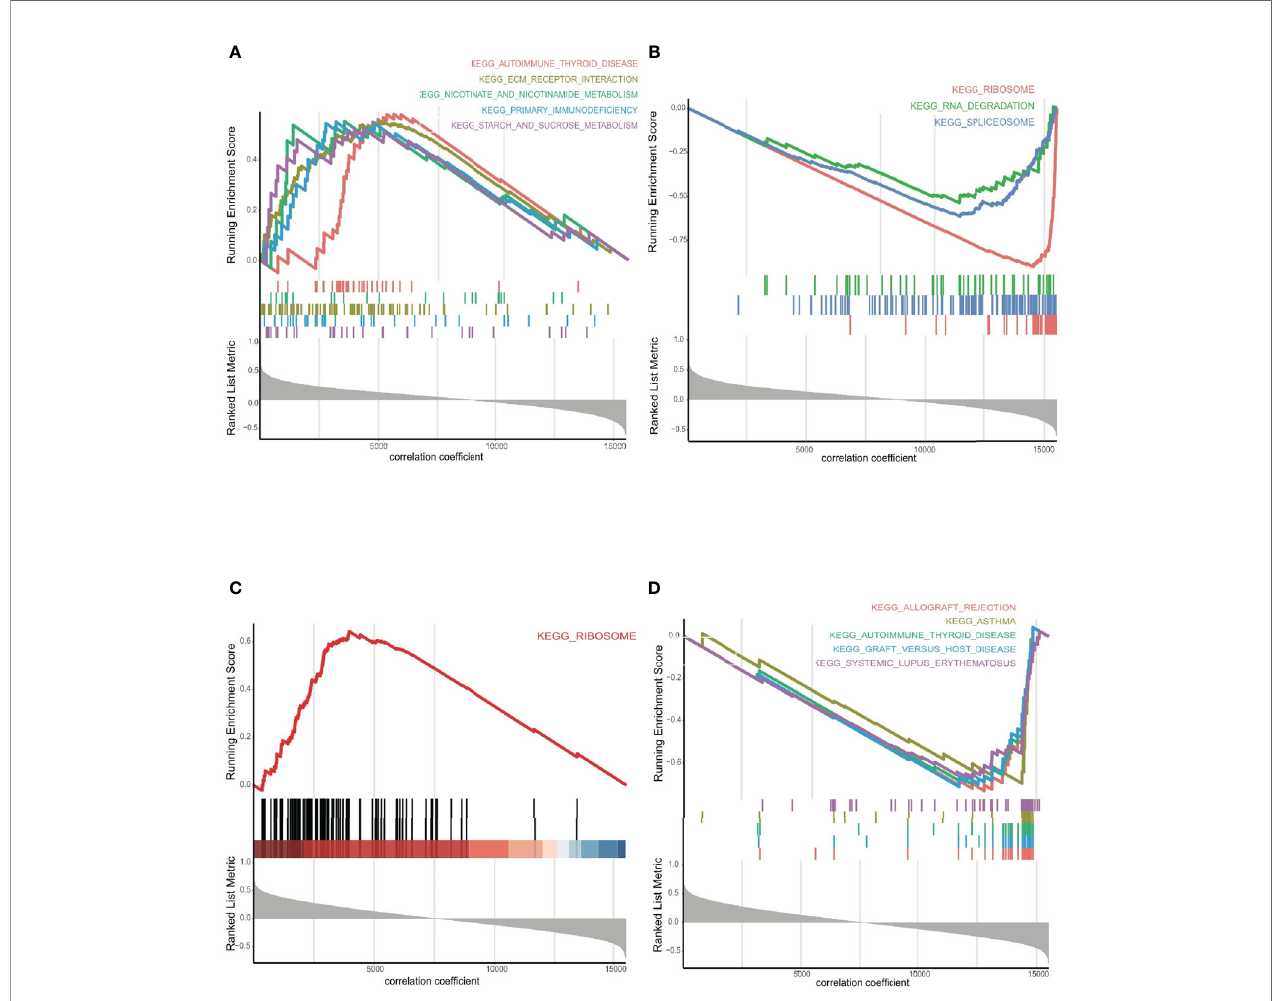
FIGURE 6 | (A) The GSEA for RYR3 in positive, and (B) negative groups, respectively. (C) The GSEA for SEMA4G in positive, and (D) negative groups,